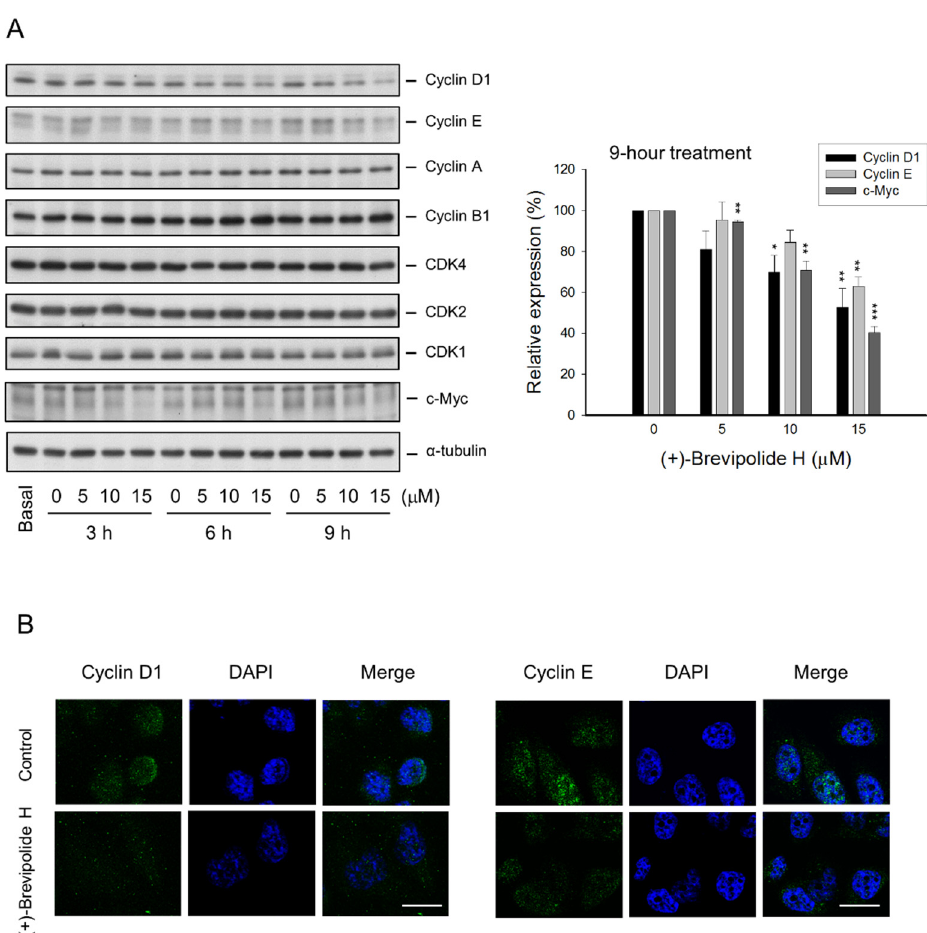
Figure 3. E ff ect of ( + )-brevipolide H on the expression of cell cycle related proteins. ( A ) PC-3 cells were incubated in the absence or presence of ( + )-brevipolide H for the indicated concentrations and times. The cells were then collected and lysed for the detection of protein expression by Western blot analysis. Quantitative data of the relative expression under 9-h treatment are expressed as mean ± SEM of three independent experiments using Bio-Rad Image Lab TM Software (Bio-Rad, Hercules, CA, USA). The * p < 0.05, ** p < 0.01, and *** p < 0.001 compared with the control. ( B ) PC-3 cells were starved at fetal bovine serum (FBS)-free medium for 24 h and then incubated in FBS-containing (10%) medium in the absence or presence of ( + )-brevipolide H (15 µ M) for 3 h. The confocal immunofluorescence microscopic examination was performed. Bar , 20 µm.